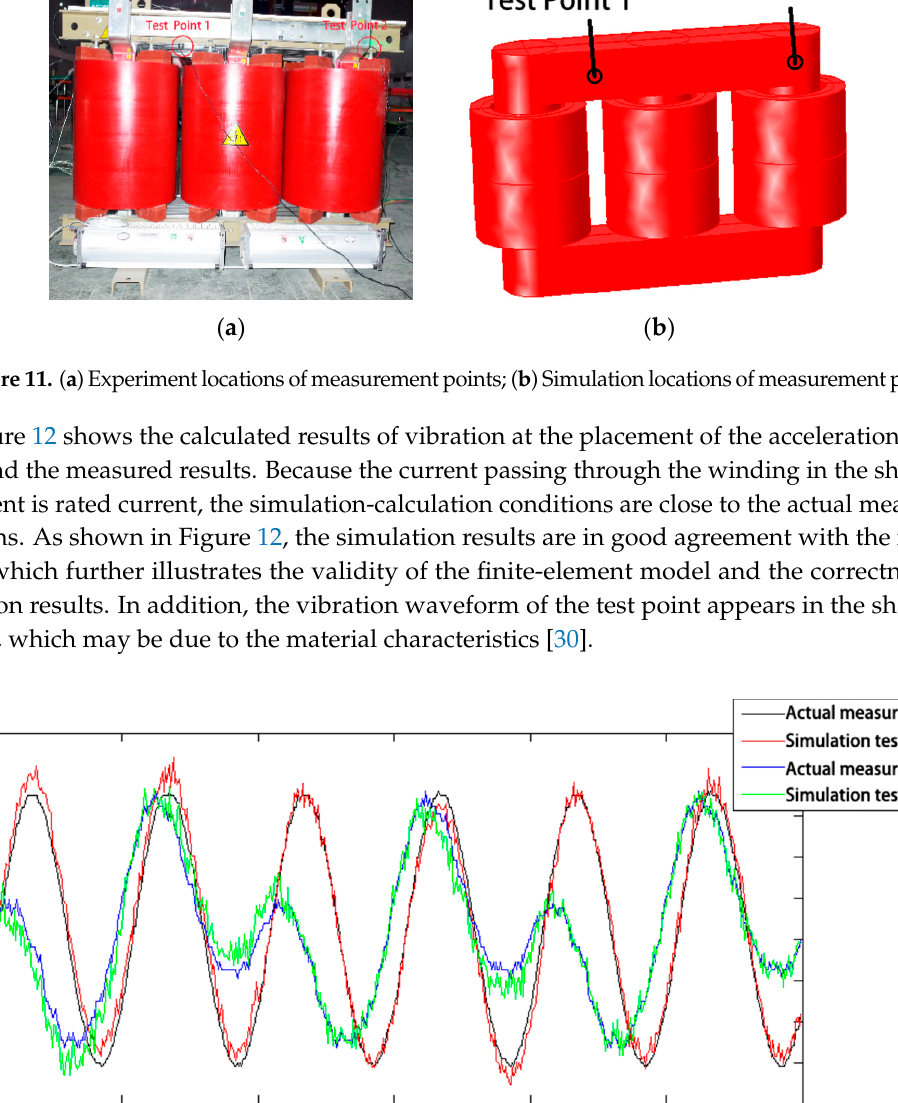
Figure 12. Comparison of vibration signals at each test point.